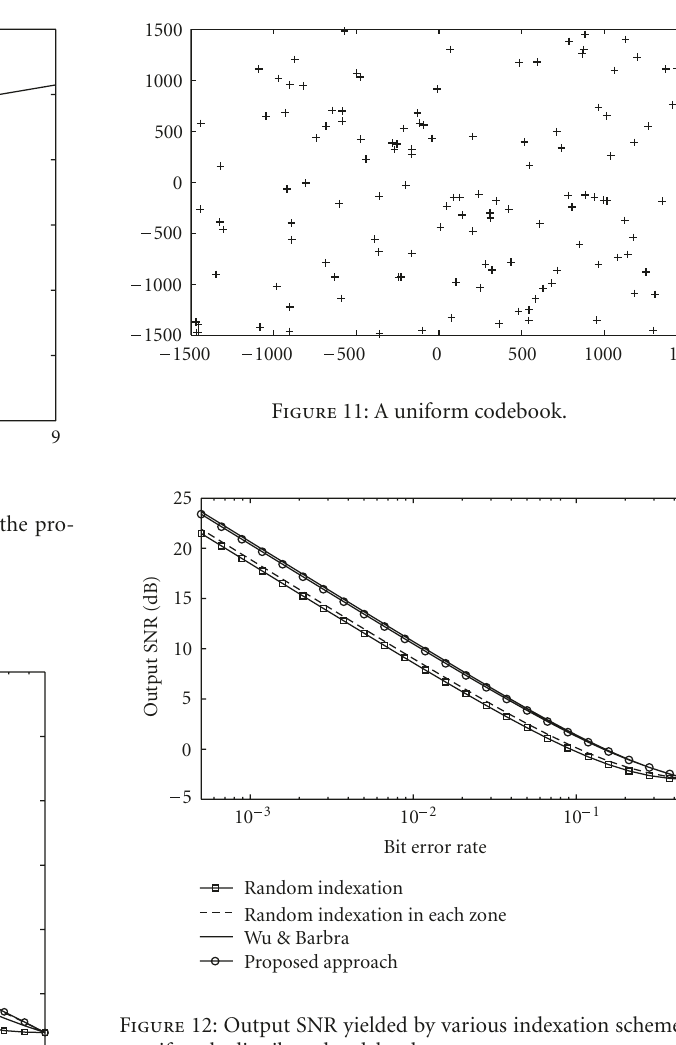
Figure 12: Output SNR yielded by various indexation schemes on a uniformly distributed